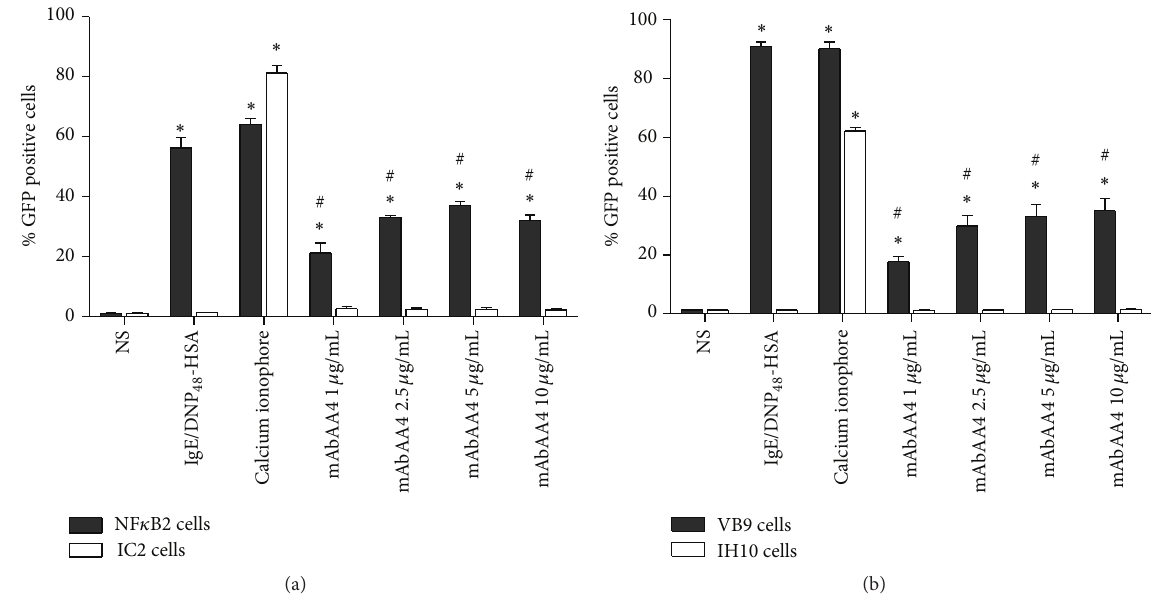
Figure 5: Cross-linking GD1b derived gangliosides by mAbAA4 induced the activation of the transcription factors NF 𝜅 B and NFAT. NF 𝜅 B2 cells, VB9 cells, IC2 cells, and IH10 cells were sensitized with IgE anti-TNP and stimulated with DNP 48 -HSA (50 ng/mL) for 1h and rinsed and cultured for additional 5 h ((a); NF 𝜅 B) or 15 h ((b); NFAT). For Fc 𝜀 RI independent stimulation, the cells were incubated with calcium ionophore (0.1 𝜇 g/mL). To cross-link GD1b derived gangliosides, cells were incubated with mAbAA4 (1, 2.5, 5, and 10 𝜇 g/mL). GFP expression was analyzed by flow cytometry. Data is expressed as the mean ± SD of three independent experiments. ∗ 𝑃 < 0.05 between experimental samples and the nonstimulated (NS) cells. # 𝑃 < 0.05 between experimental samples and Fc 𝜀 RI stimulated